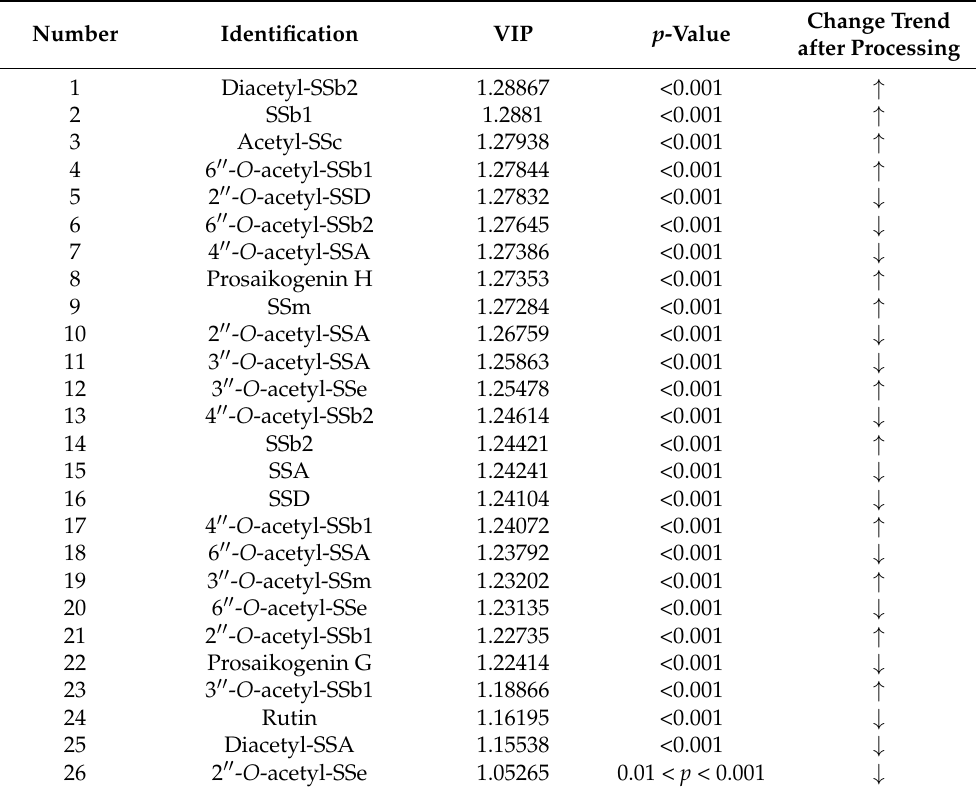
Table 2. The characterized compounds of BC changed after processing.